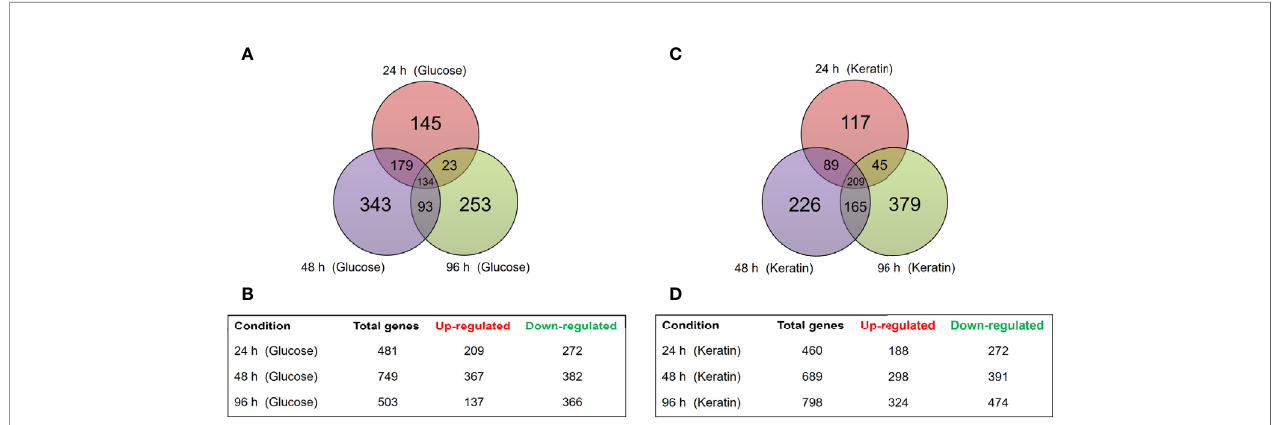
FIGURE 1 | Time-dependent distribution of differentially expressed genes (DEGs) in the D stuA strain compared with that in the wild-type during growth on glucose or keratin sources. (A) Venn diagram illustrates the number of transcripts modulated in D stuA T. rubrum grown in glucose medium for 24, 48, or 96 h compared to wild-type. (B) Number of DEGs at each time point during D stuA T. rubrum growth in glucose. (C) Venn diagram illustrates the number of transcripts modulated at each time point in D stuA T. rubrum grown in keratin-supplemented medium. (D) Number of DEGs in D stuA T. rubrum grown on keratin for 24, 48, or 96